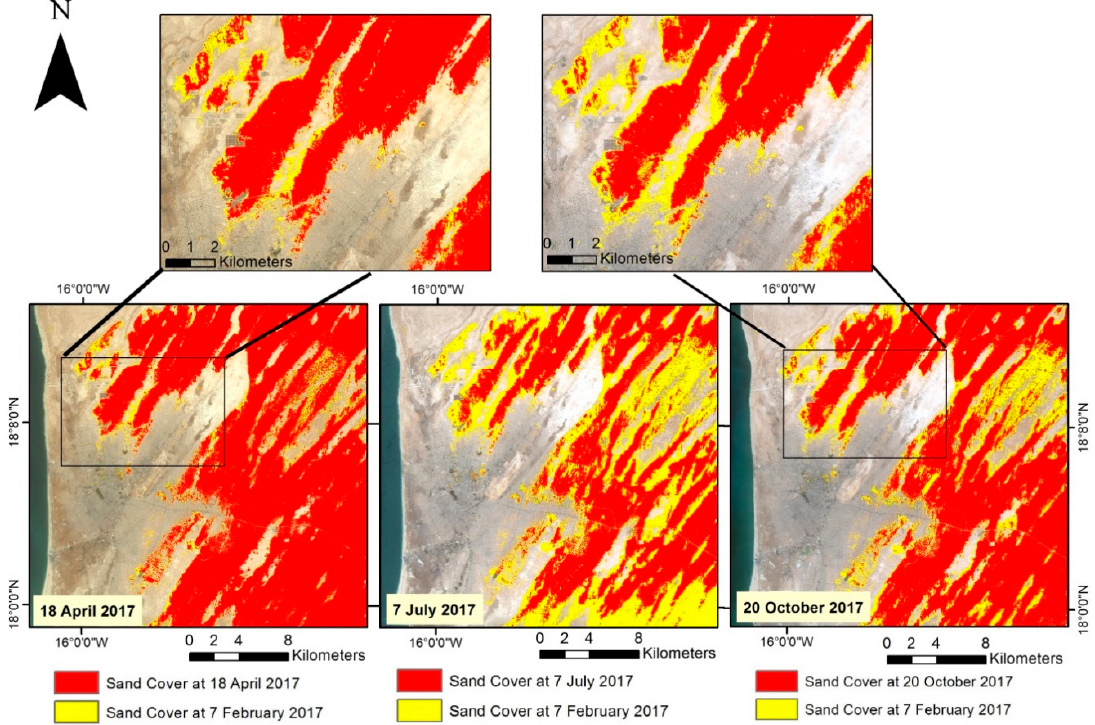
Figure 9. Sand dune changes during 2017 taking the image from 7 February 2017 (yellow) as a reference.